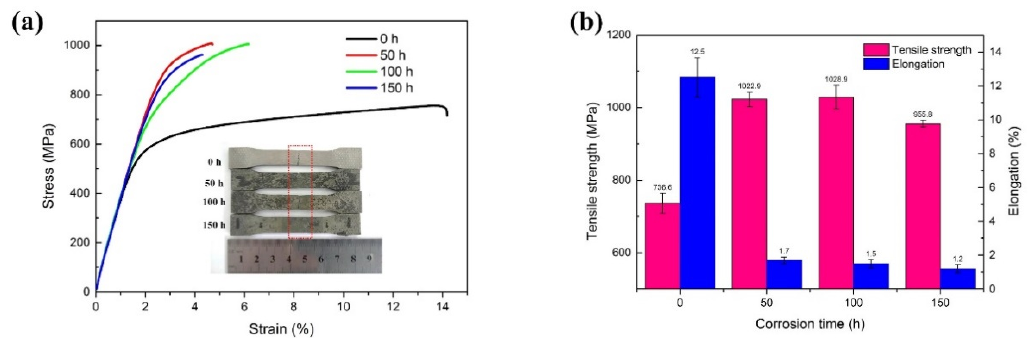
Figure 11. ( a ) The stress–strain curves and ( b ) mechanical properties of laser-repaired Inconel 718 alloy specimen exposed to the molten salt at 650 °C for different corrosion times.